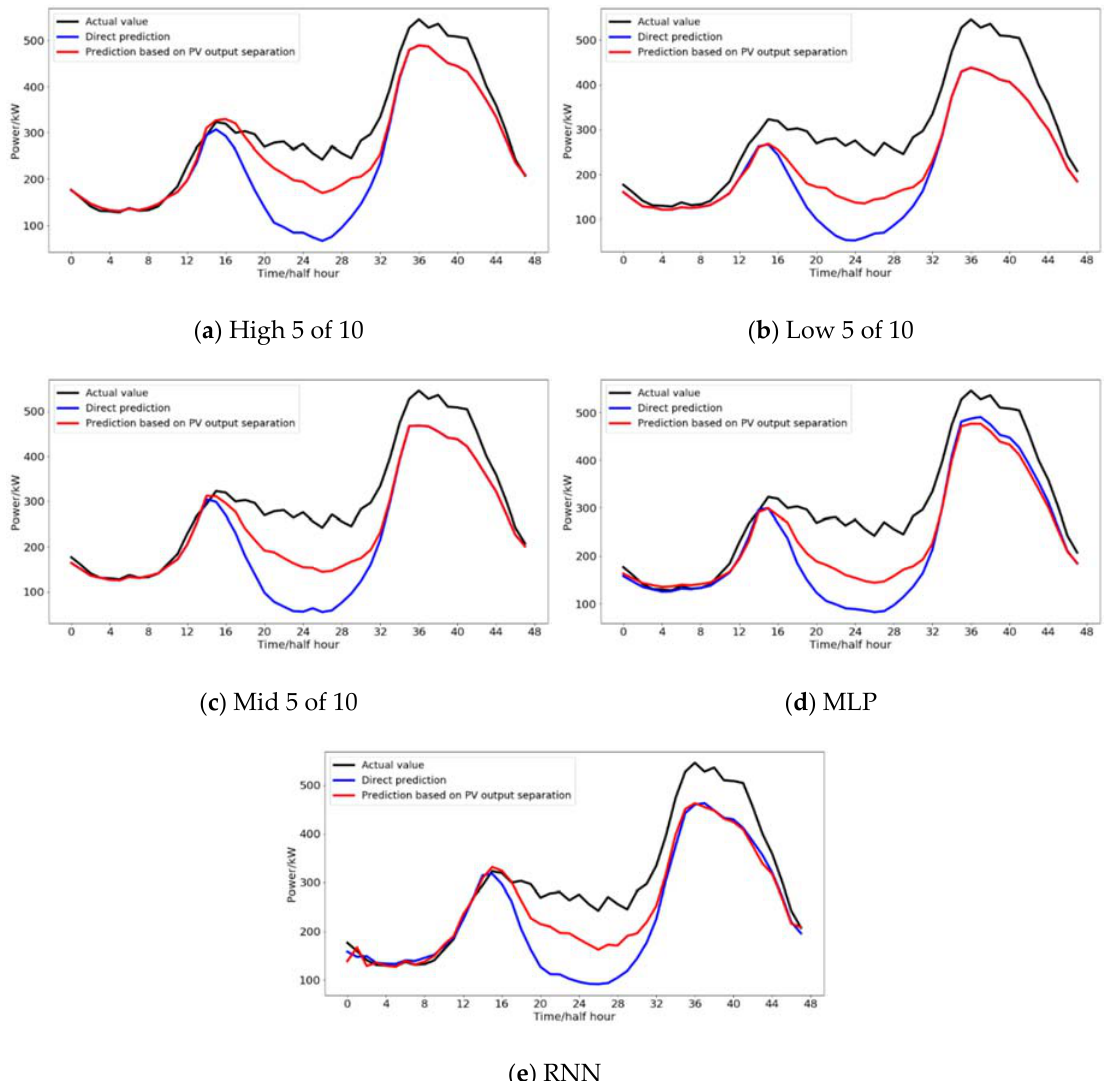
Figure 7. Comparison of direct prediction and customer baseline (CBL) prediction results based on PV output curve decomposition on a certain demand response (DR) day. Table 4. Average evaluation results of CBL prediction for overall days under different methods.